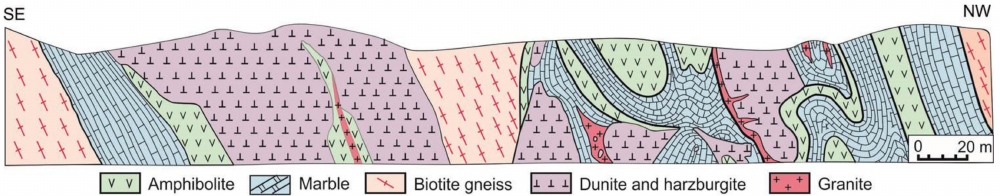
Figure 7. Geological cross section of Sakhyurta peridotite in a cli ff exposure, modified after